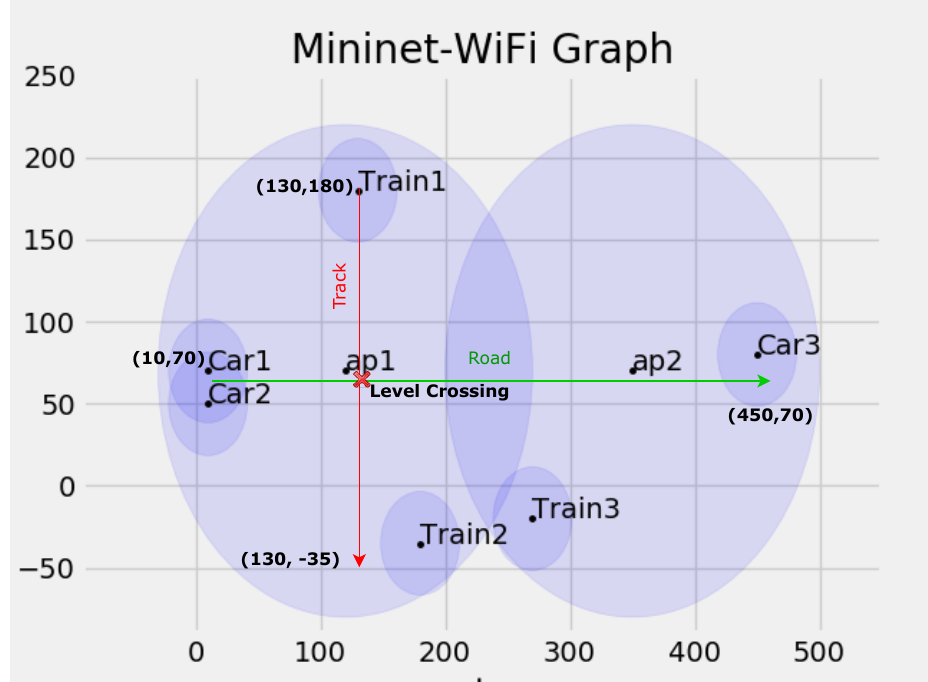
Figure 6. S4(5/6)4 hosts and access points: Mininet–WiFi graph.